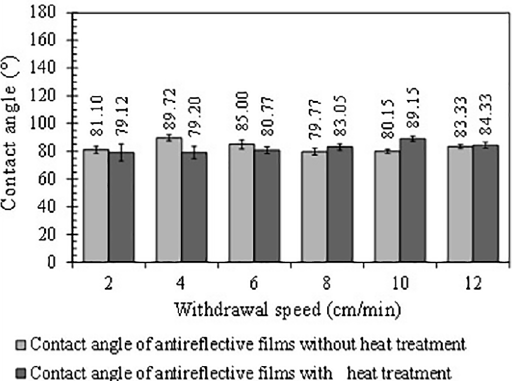
Figure 5. Results of wettability tests for all antireflective